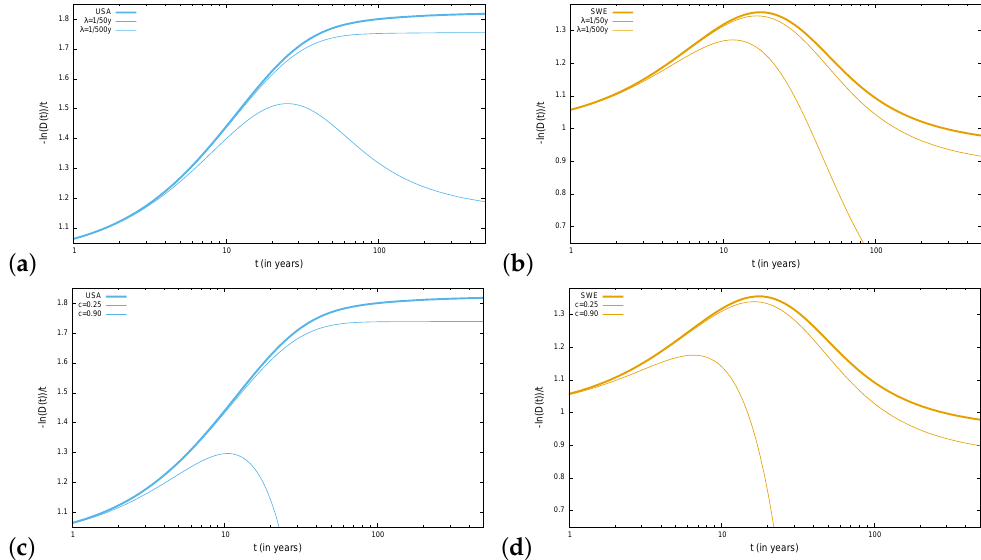
Figure 3. Discount function for Laplacian jump amplitudes with c < 1 (cf. Equations (65) and (66)) as a function of time (in years) and for different jumps time frequency λ . We take the Ornstein– Unlenbeck parameters estimated somewhere else with initial interest rate r 0 = 1% [17] with United States of America (USA) and Sweden (SWE) dates, which are considered to be stable countries. ( a , b ) we explore the effect of increasing jumps time frequency (thinner lines, 1/ λ = {500 and 50 years}) while fixing jumps amplitude ( c = 0.5, cf. Equation (64)). The panel figures ( a , b ) show that the higher the frequency, the lower the discount function curve. The panel figures ( c , d ) explore the effect of increasing jumps amplitude (thinner lines, c = {0.2, 0.9}) while fixing jumps frequency (1/ λ = 50 years). The higher the c (jump size), the lower the discount. The case of the United States of America (USA), whose Ornstein–Uhlenbeck estimated parameters are ˆ m = 0.0319 year − 1 , ˆ α = 0.0603 year − 1 , ˆ k 2 = 10.03 × 10 − 5 year − 3 . The case of Sweden (SWE), whose Ornstein–Uhlenbeck estimated parameters are ˆ m = 0.0279 year − 1 , ˆ α = 0.0676 year − 1 , ˆ k 2 = 16.9 × 10 − 5 year − 3 . From this case, we conclude that if jump amplitudes are on average smaller than the √ restoring force toward the normal level ( γ < α 2) jumps reduce the long-run discount rate. √ However, when jump amplitudes are larger ( γ > α 2), the discount function becomes infinite at a finite